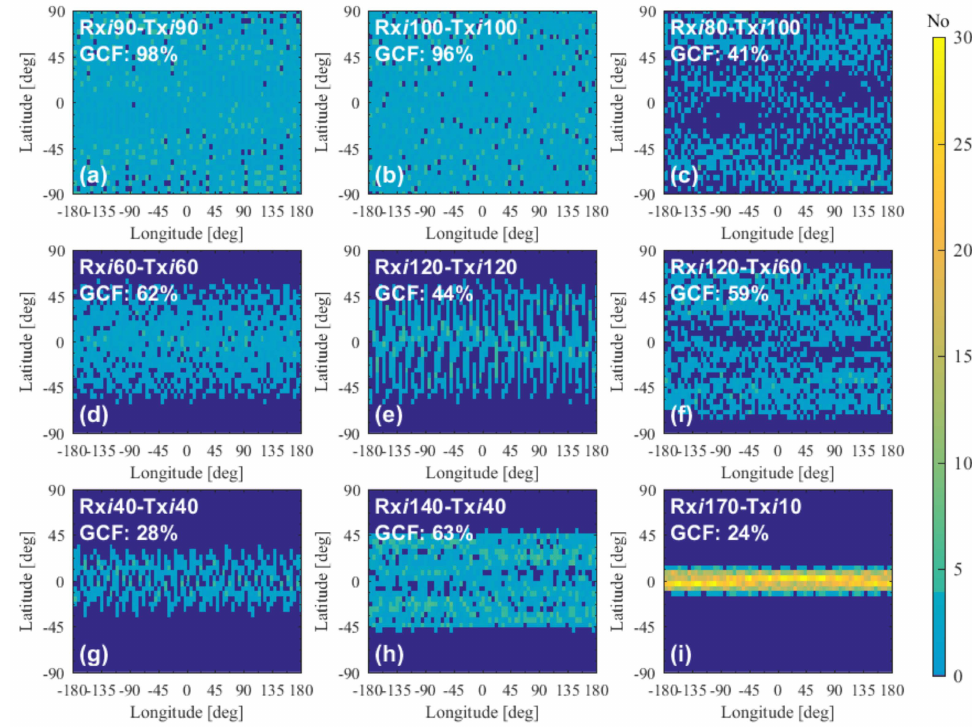
Figure 3. The global coverage of LEO-LEO occultation events for representative constellations composed of a Rx satellite and a Tx satellite with particular orbital inclinations, illustrating the occultation numbers per 5 ◦ × 5 ◦ latitude and longitude grid cell, while the GCFs were calculated using grid cell areas according to Equation (12).